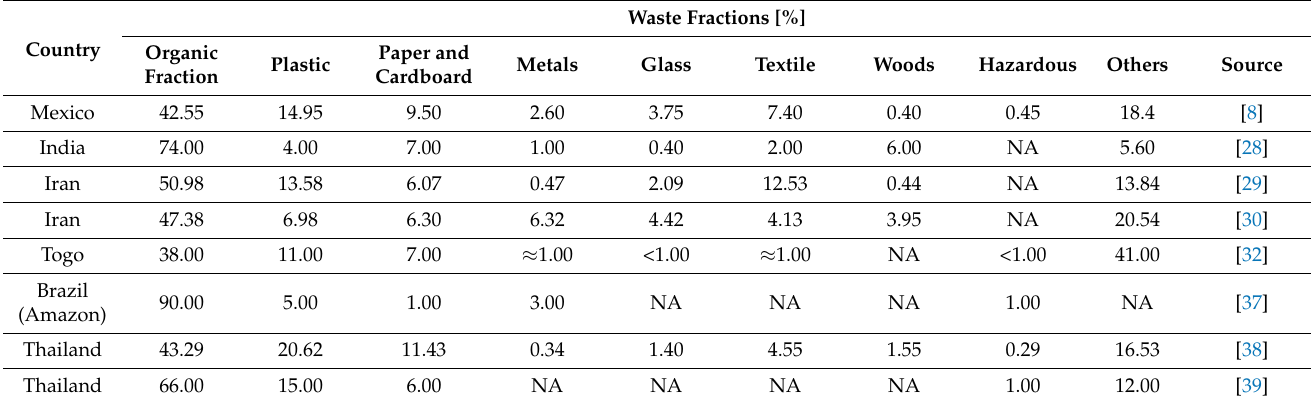
Table 2. Waste composition in rural communities of developing